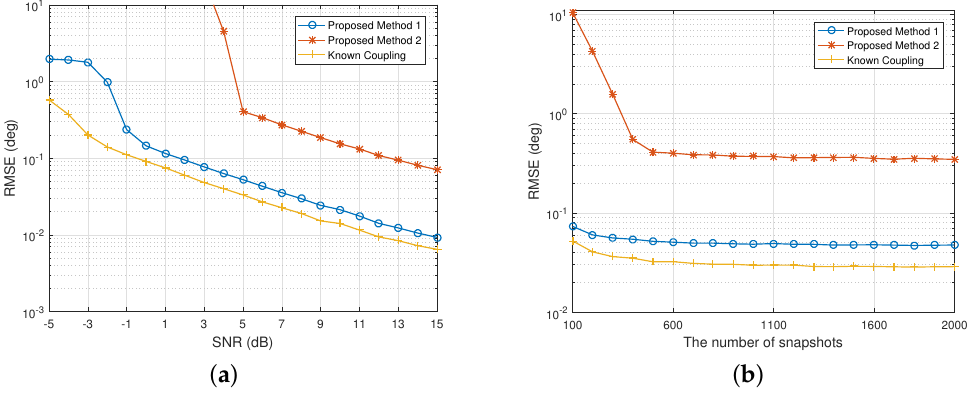
Figure 1. RMSE of the DOA estimates of 2 independent signals versus ( a ) SNR when N = 500; ( b ) N when SNR = 5 dB.